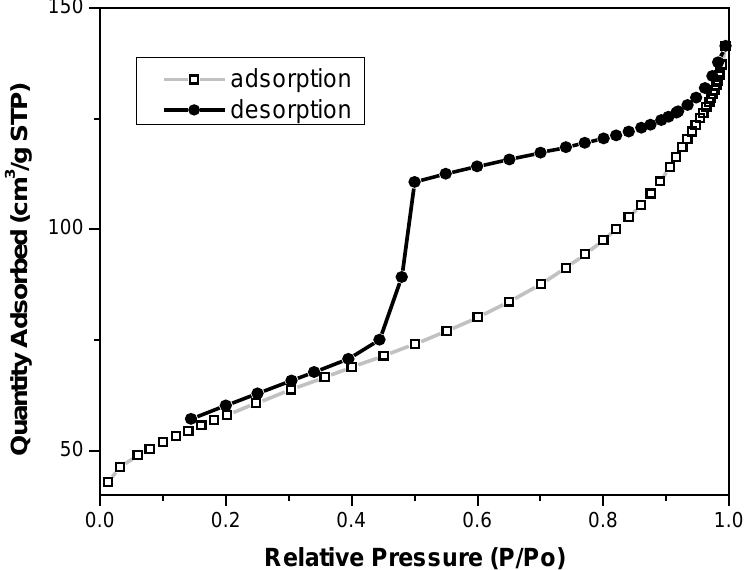
Figure 3. Nitrogen adsorption and desorption isotherm for PKS-Fe 1000 °C.